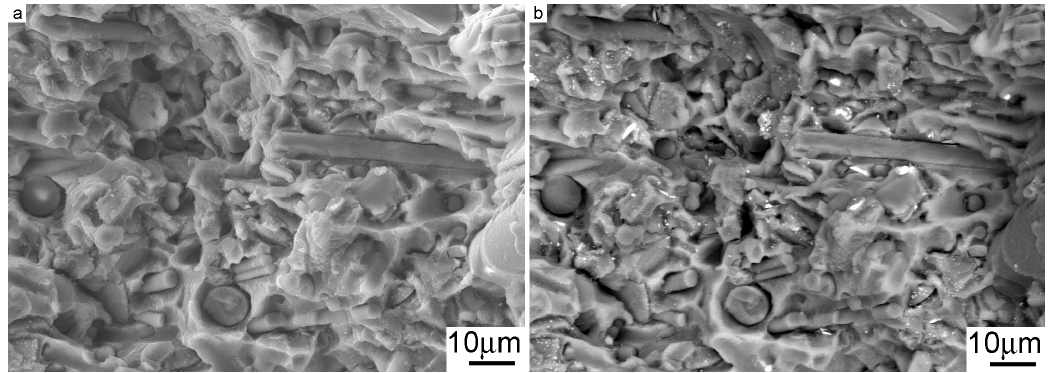
Figure 7. Fracture surface of the hybrid composite after straining in the tension test ( a ); the same location taken in BSE mode ( b ).